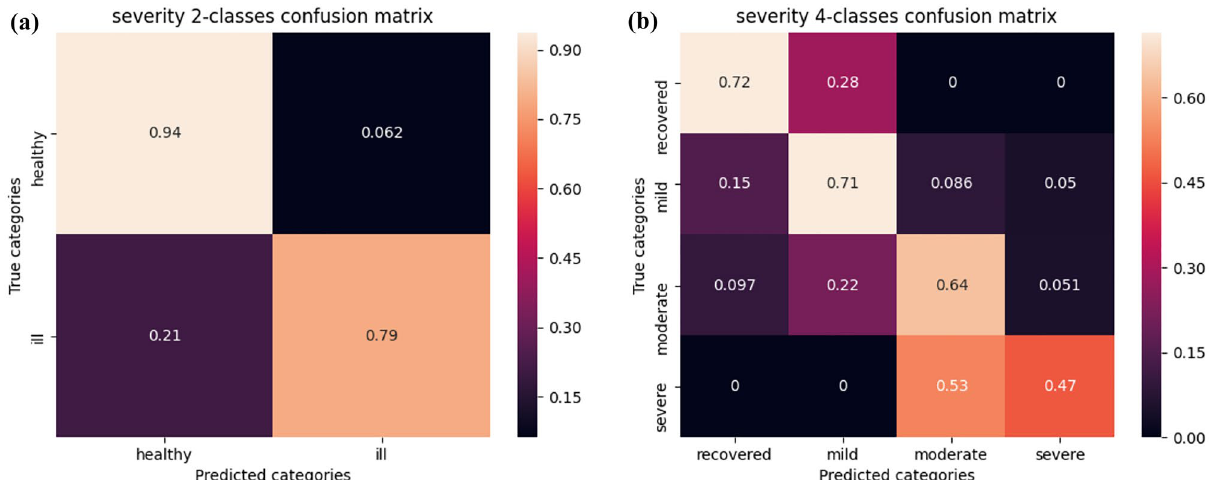
Figure 5. Confusion matrices of our categorical predictions. ( a ) Left: Normalized confusion matrix of our model’s 2-class prediction for the test set. The model had a true negative rate of 94%, which can be explained by the tendency of the optimistic model to output a recovery prediction. ( b ) Right: Normalized confusion matrix of our model’s 4-class prediction for the test set. Errors far from the diagonal are zero or close to zero. Notably, our model never misclassifies recovered and severe depression or vice versa.